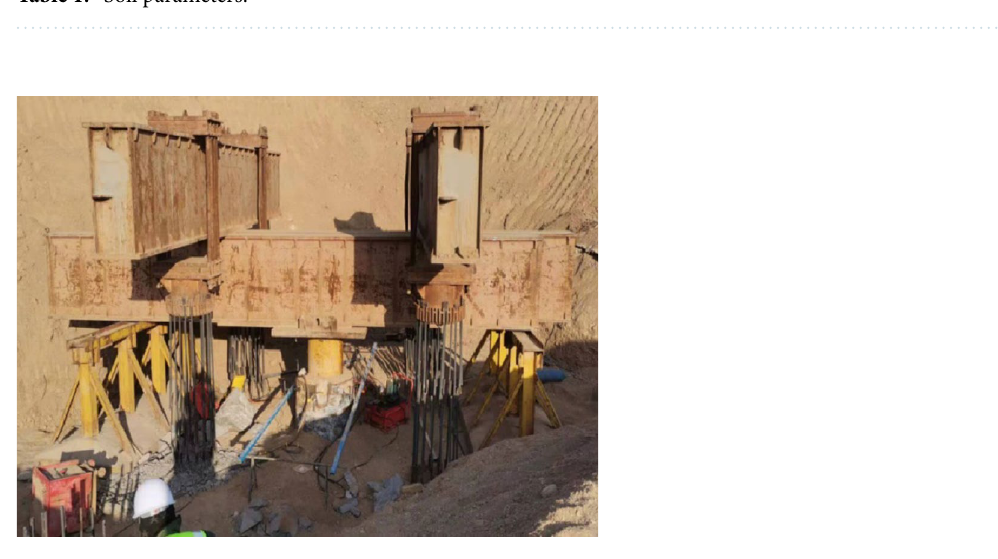
Table 1. Soil parameters.